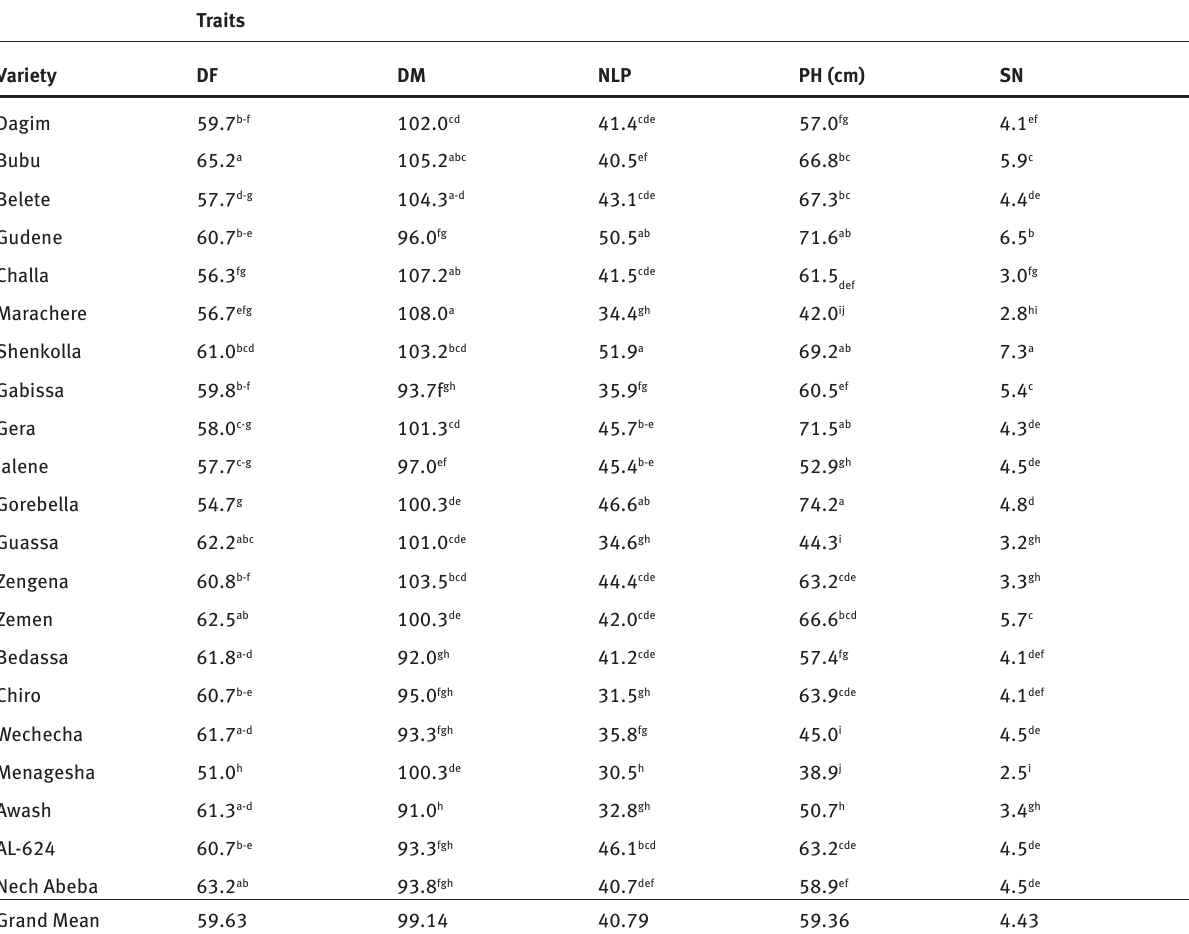
Table 4: Mean performances of 21 potato varieties for phenology and growth traits evaluated at Holetta and Adea Berga in 2017